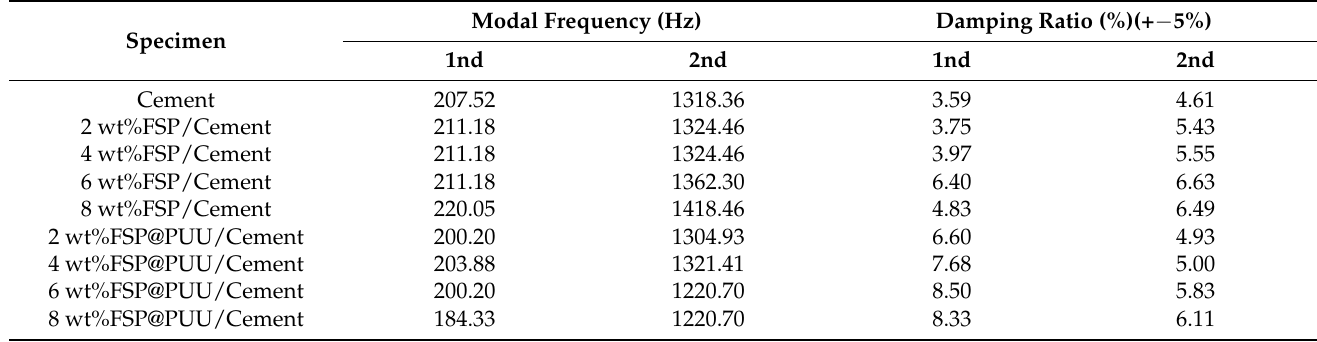
Table 3. Modal frequency and damping ratio of Cement, FSP/cement and